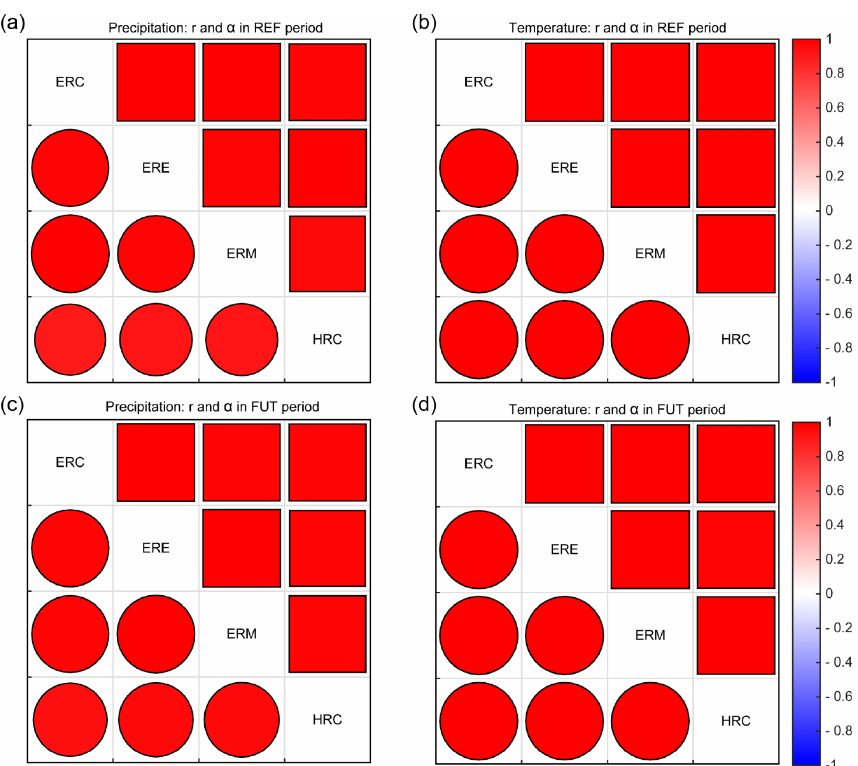
Figure 5. Results of the analysis of agreement for mean monthly precipitation (a, c) and temperature (b, d) among the four climate models (ERC: ECH-RCA, ERE: ECH-REM, ERM: ECH-RMO, HRC: HCH-RCA) for the reference (REF, 1971–2000, a, b ) and future (FUT, 2041–2070, c, d )